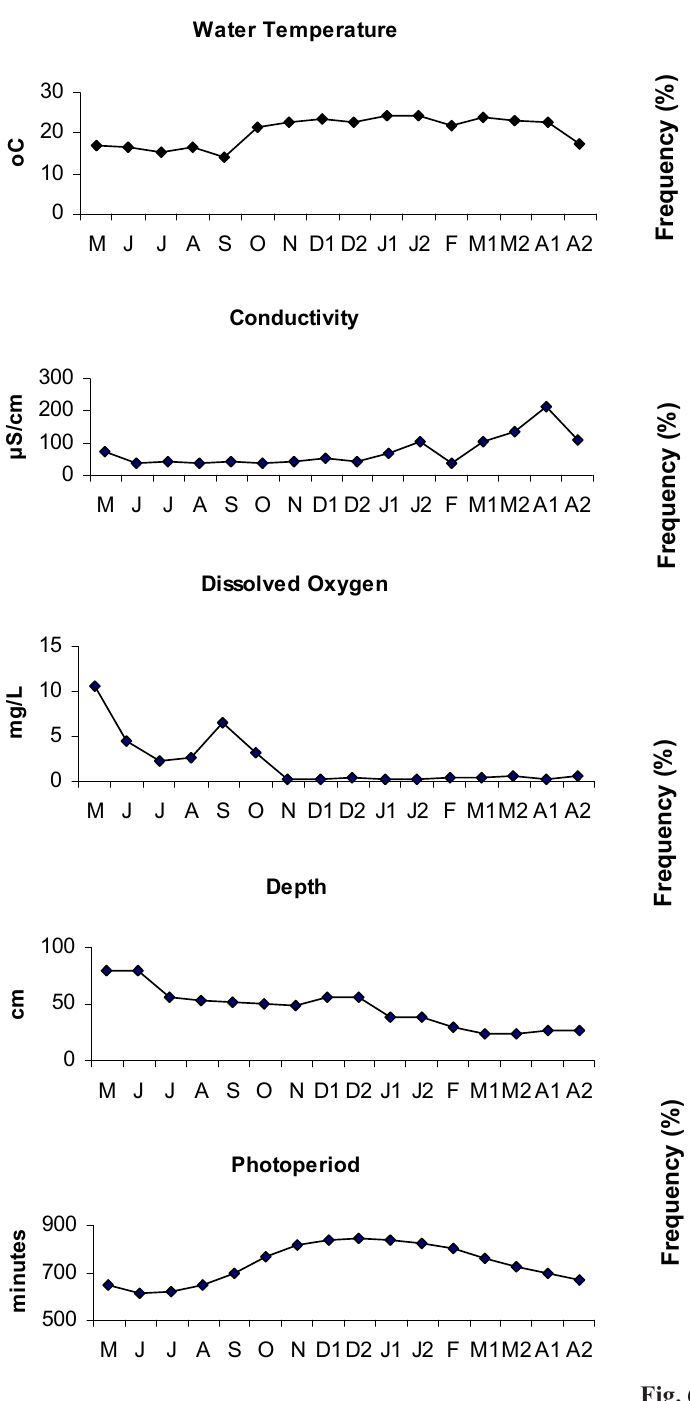
Fig. 5. Monthly variation of abiotic factors in lagoa Verde, Itapuã State Park.